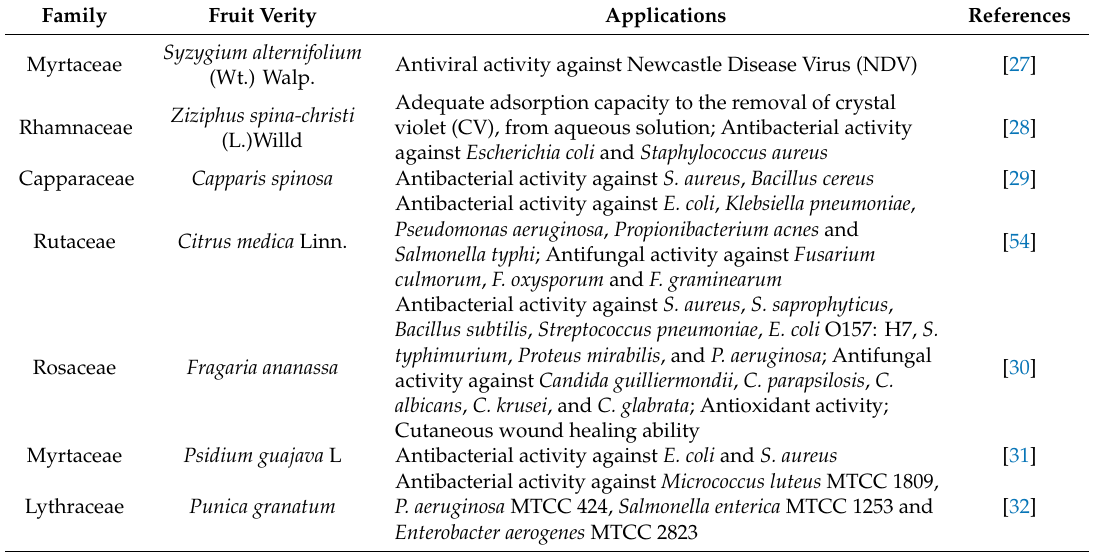
Table 3. Applications of copper oxide NPs synthesized from various fruit varieties.